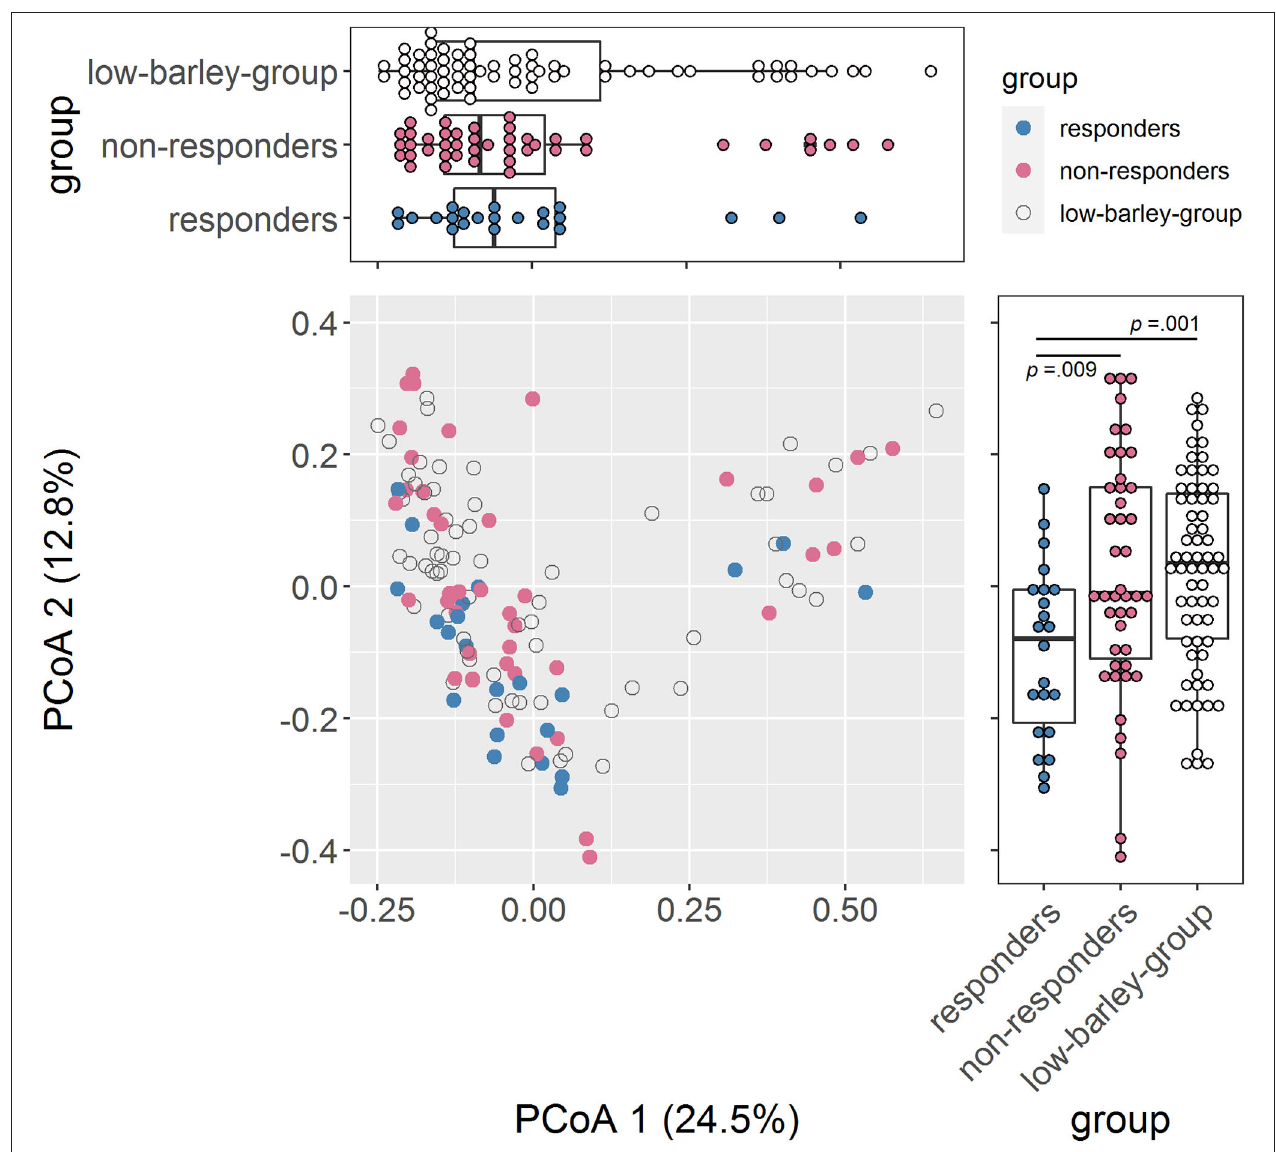
FIGURE 2 | Comparison of the gut microbiome composition. PCoA of gut microbiome based on 266 genera